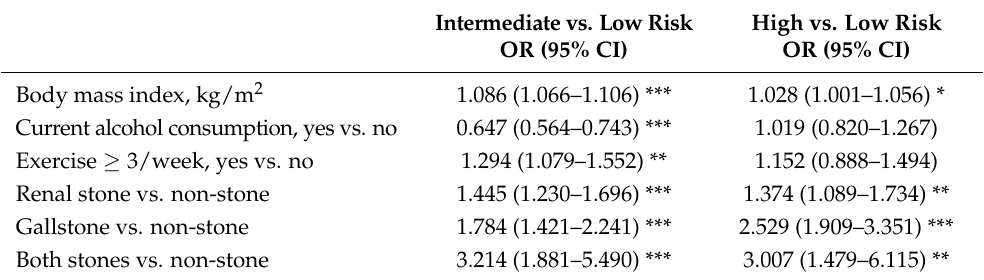
Table 2. Multinomial logistic regression models for the associations of stone status with intermediate and high levels of ASCVD risk, with a non-stone group for reference.